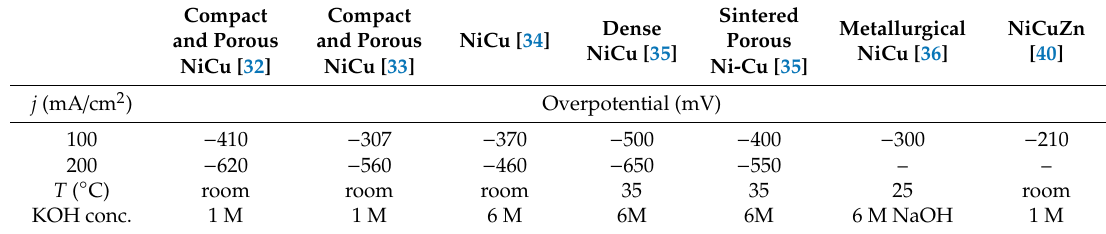
Figure 4. ( a ) Polarization curves for several catalysts for HER at 30 ◦ C (Ni was not aged). ( b ) Comparison of aged Ni and Ra–Ni between 30 and 100 ◦ C. Table 1. Summary of NiCu alloys found in literature for HER in alkaline conditions.